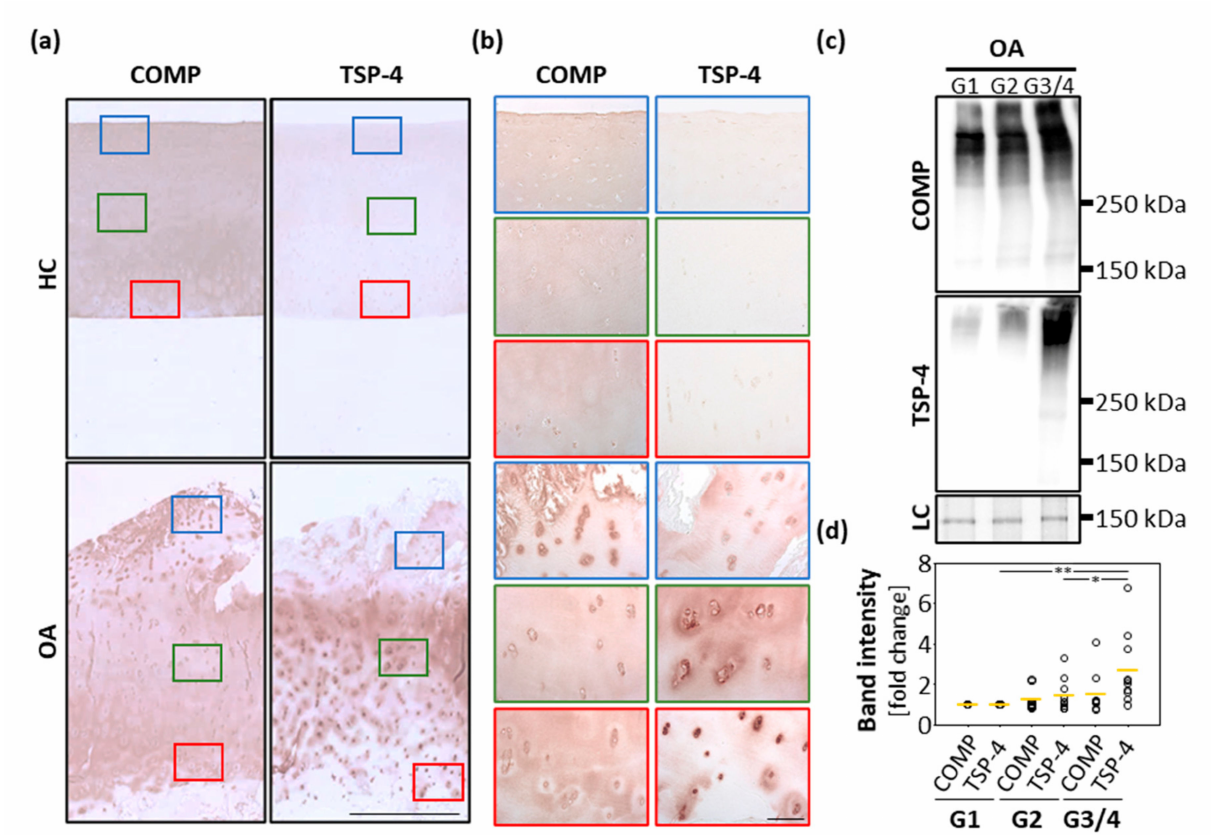
Figure 1. Localization and expression of COMP and TSP-4 in human articular cartilage. ( a ) Articular cartilage sections from femoral condyles from healthy controls (HC) and OA patients (OA) were stained with COMP and TSP-4 specific antibodies. Scale bar = 1 mm. ( b ) Magnifications of tissue areas indicated with the boxes in ( a ). Scale bar = 100 µ m. ( c ) Total COMP and TSP-4 content was investigated via immunoblots, with proteins extracted from OA cartilage areas showing different degeneration grades (grade 1 (G1), grade 2 (G2) and grade 3/4). PageBlue TM staining was used as loading control (LC). Representative immunoblots from 10 different donors are shown. ( d ) Quantification and statistical analyses of the immunoblots. Values are represented as scatter plots with indicated mean as fold changes to G1 (set as 1). The significance of the increase in COMP and TSP-4 is indicated ( p < 0.05 *, p < 0.01